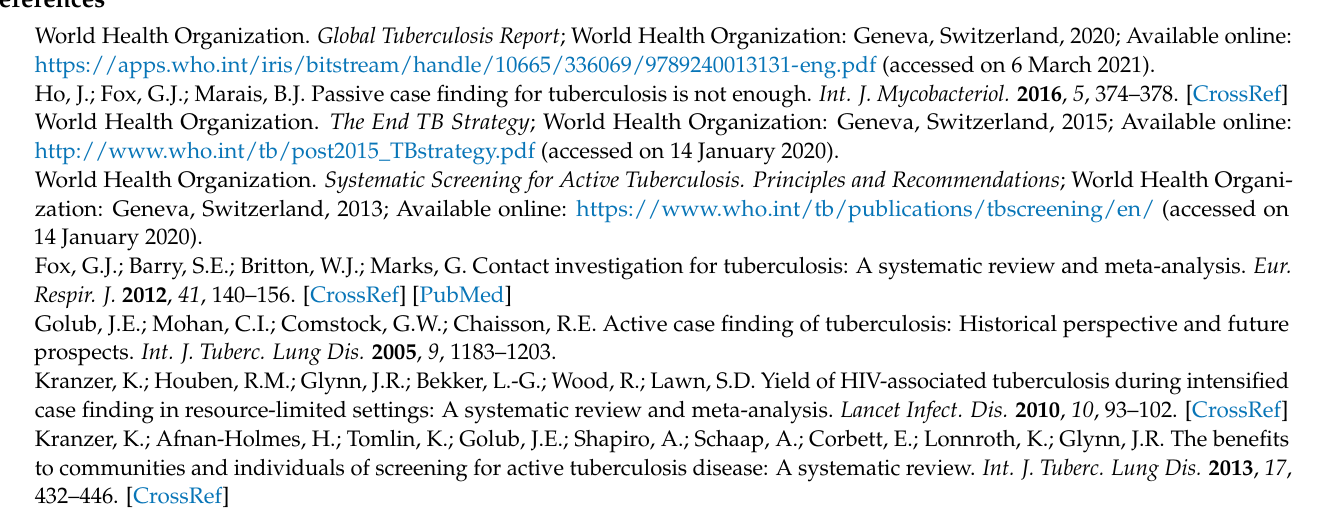
Table S1: Summary of the completeness of reporting of the ACF activities, Table S2: Summary data from the NTEP for active case finding (ACF) activities in India (2018) and Table S3: Summary data from the NTEP for active case finding (ACF) activities in India